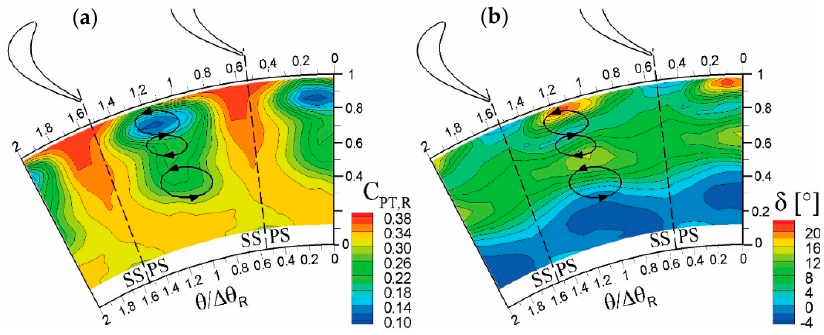
Figure 13. Rotor-exit relative flow field in OPLU, ( a ) relative total pressure coefficient; ( b ) deviation angle.